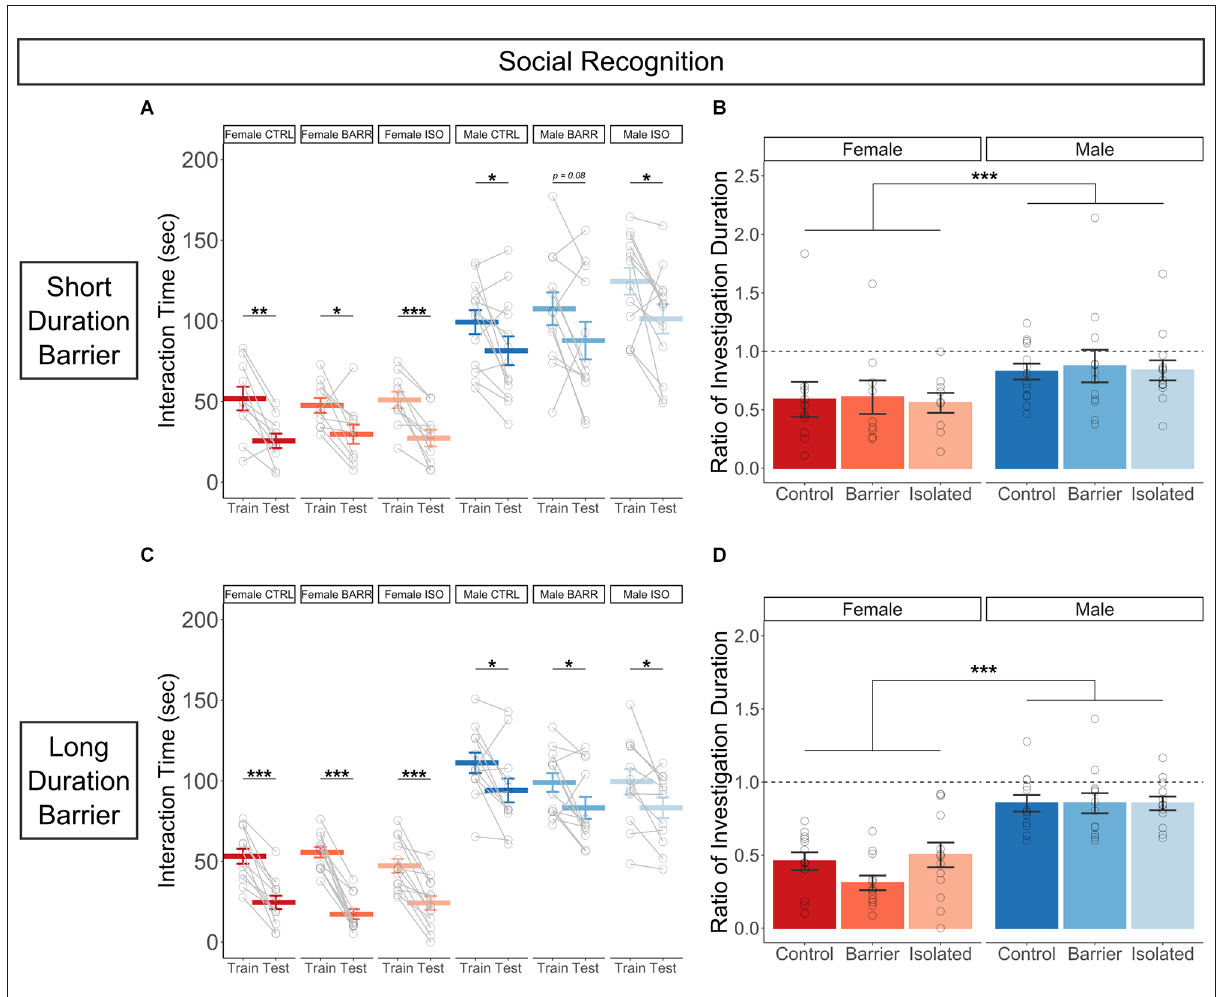
FIGURE8 While juvenile play deprivation has no effect, there are sex differences in social recognition in adulthood. Quantification of the amount of time spent interacting with a stimulus rat on both the Train (first trial in which the stimulus rat is novel) and the Test (second trial following a 30 min inter-trial interval in which the stimulus rat is now familiar) trials (A) and the ratio of interaction time on the Test trial compared to that of the Train trial (B) for the short duration barrier study. The same measures are shown in (C,D) for the long duration barrier study. Bars indicate group means ± SEM, and open circles represent data from individual rats. * p < 0.05, ** p < 0.01, *** p < 0.001, n = 9–13 per